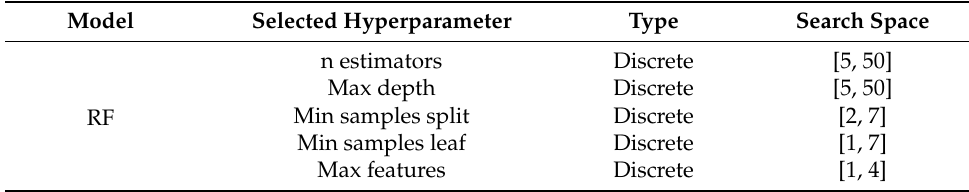
Table 3. Hyperparameter configuration.